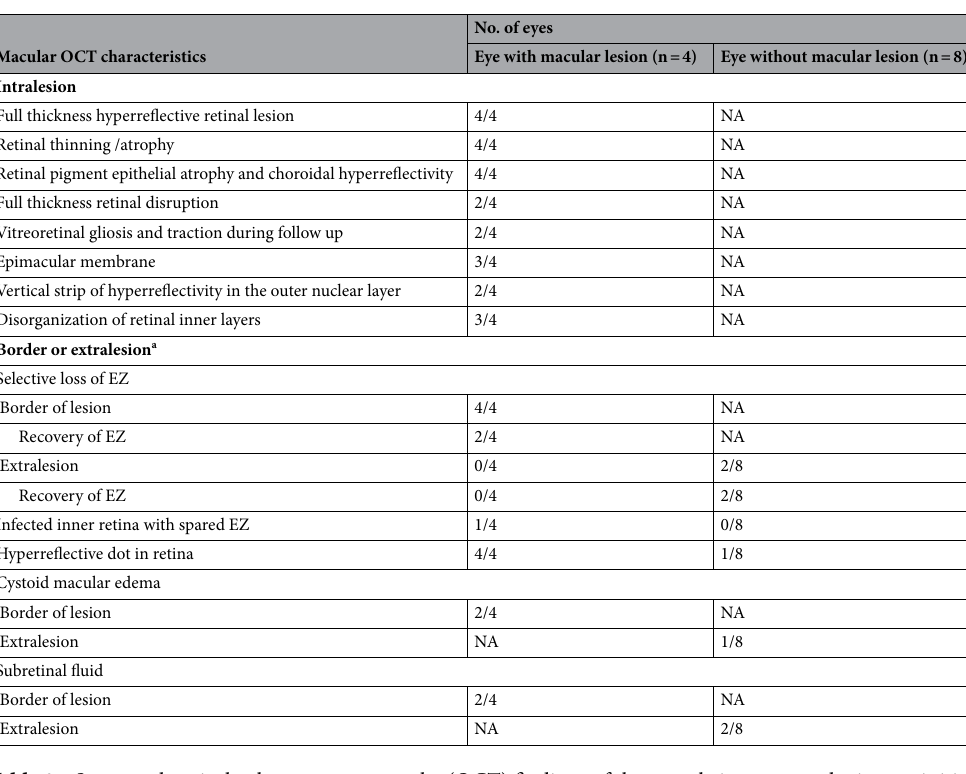
Table 2. Structural optical coherence tomography (OCT) findings of the macula in cytomegalovirus retinitis patients at the retinitis lesions, borders of the lesions and extralesional macular areas. EZ ellipsoid zone, NA not applicable. a Border of lesion defined as 500 μm within and 500 μm beyond visible margin of the lesion.